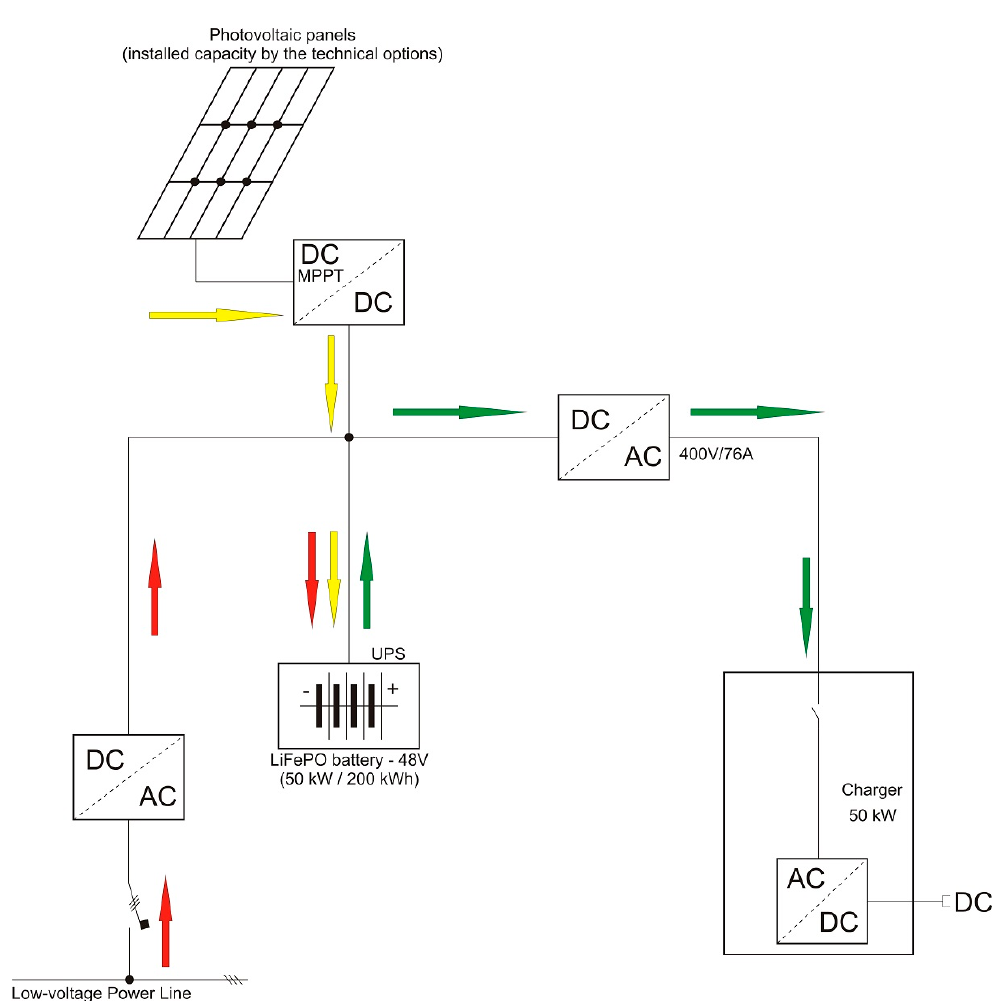
Figure 2. Concept of a charging station with renewable energy source (RES) support and accumulation [10].